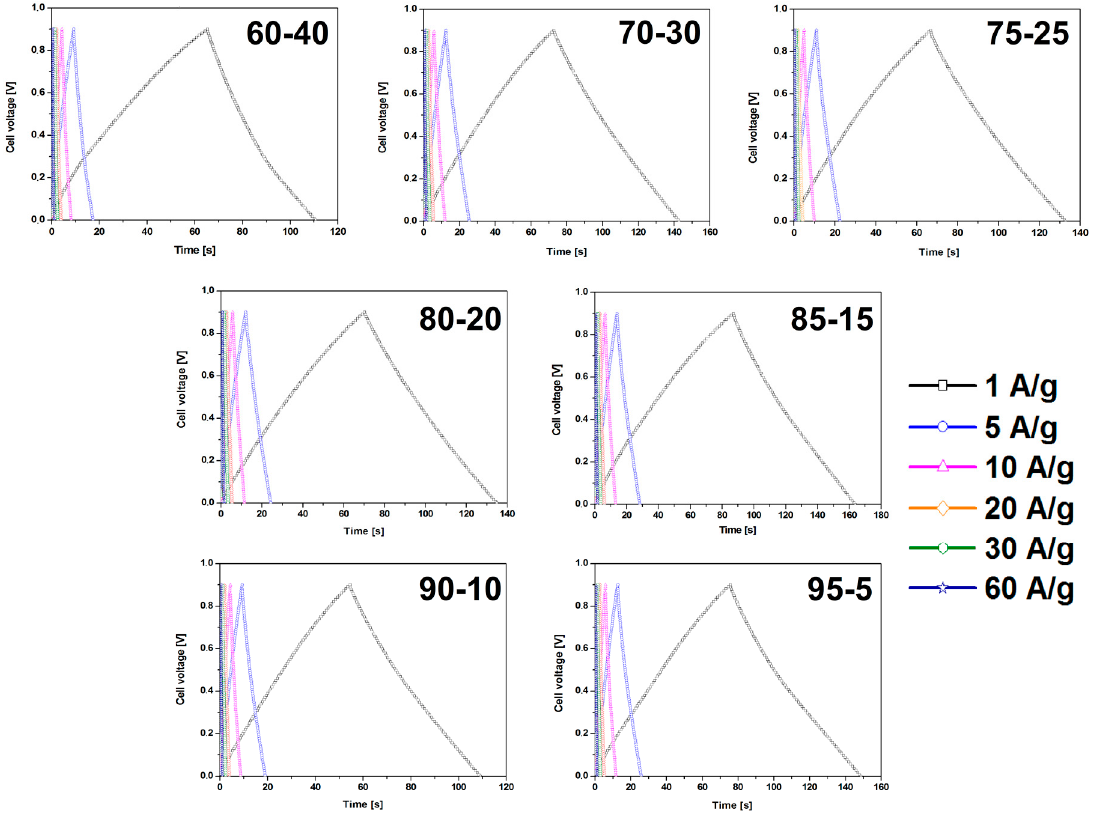
Figure 6. The GCD curves of the electrodes prepared by evaporation with different ratios of CMOF- 5:PVDF.